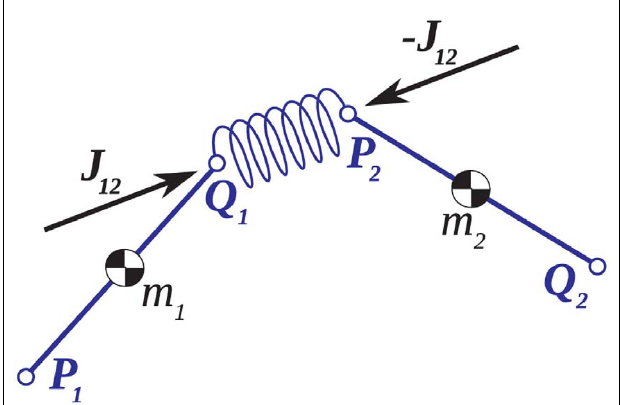
FIGUREA1 |Adjoining limb segments were bound at the joints by damped spring forces that counteracted numerical drift in the Newton-Euler method. The joint-spring shown here exerts a binding force of (cid:2) J 12 Newtons at point Q1 and an equal and opposite force on point P2. The magnitude of the spring force J is proportional to size of the joint gap. Similarly, the magnitude of the damping force (not shown) is proportional to the rate at which of the joint gap